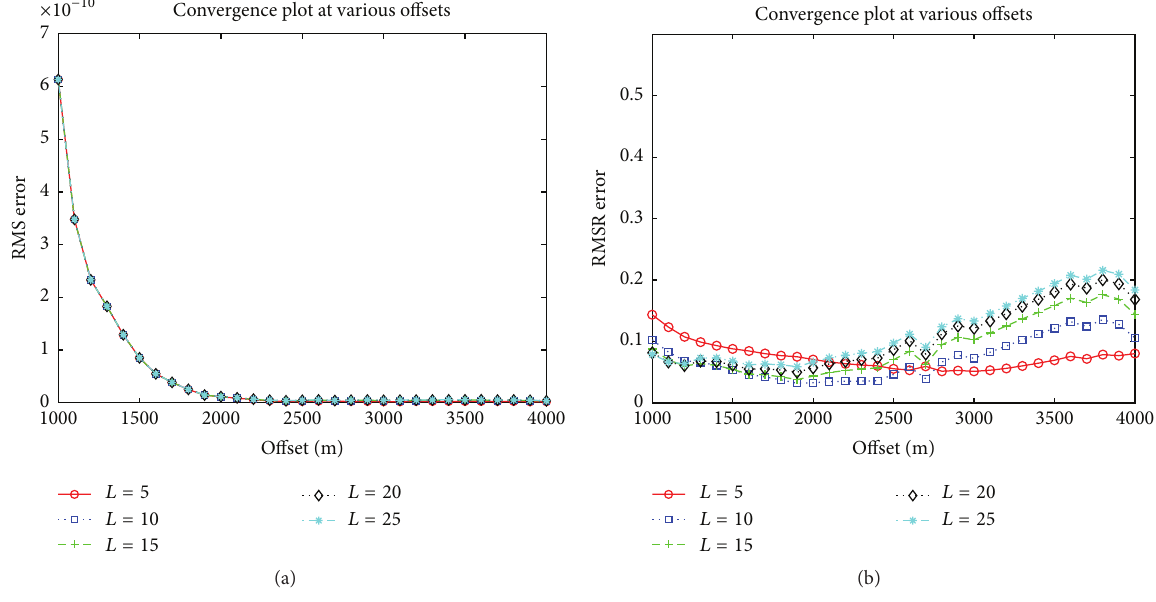
Figure 8: Convergence plot obtained by varying the size ( 𝐿 ) of the UPML region at various offsets.